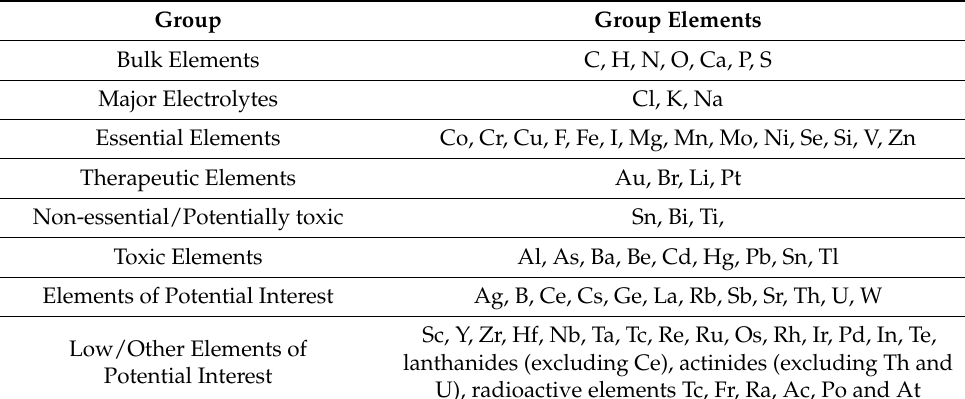
Table 1. Clinical classification of the